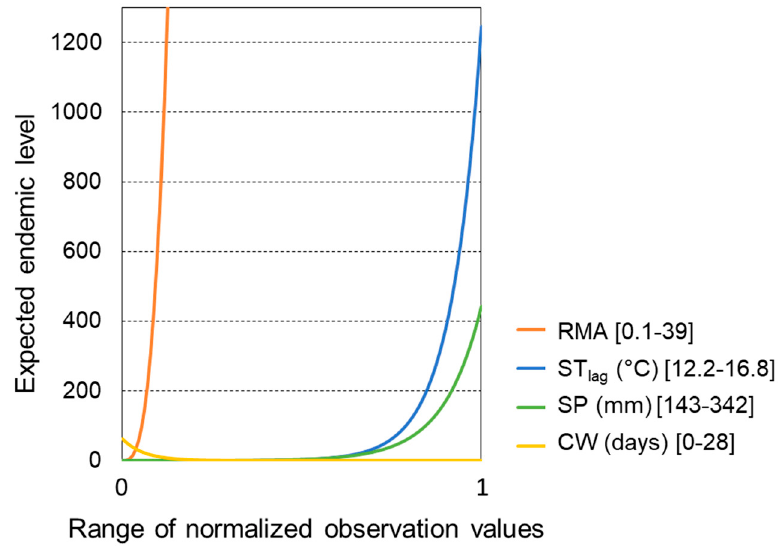
Figure 4. Sensitivity of endemic levels of tularemia to shifts in individual hydroclimate variable values within the range of past observations. The values of all variables are normalized to the same range [0–1], shown on the x-axis. The variables are: relative mosquito abundance (RMA), summer temperature in the preceding year (ST lag ), summer precipitation in current year (SP), and number of cold winter days with low snow coverage (CW).